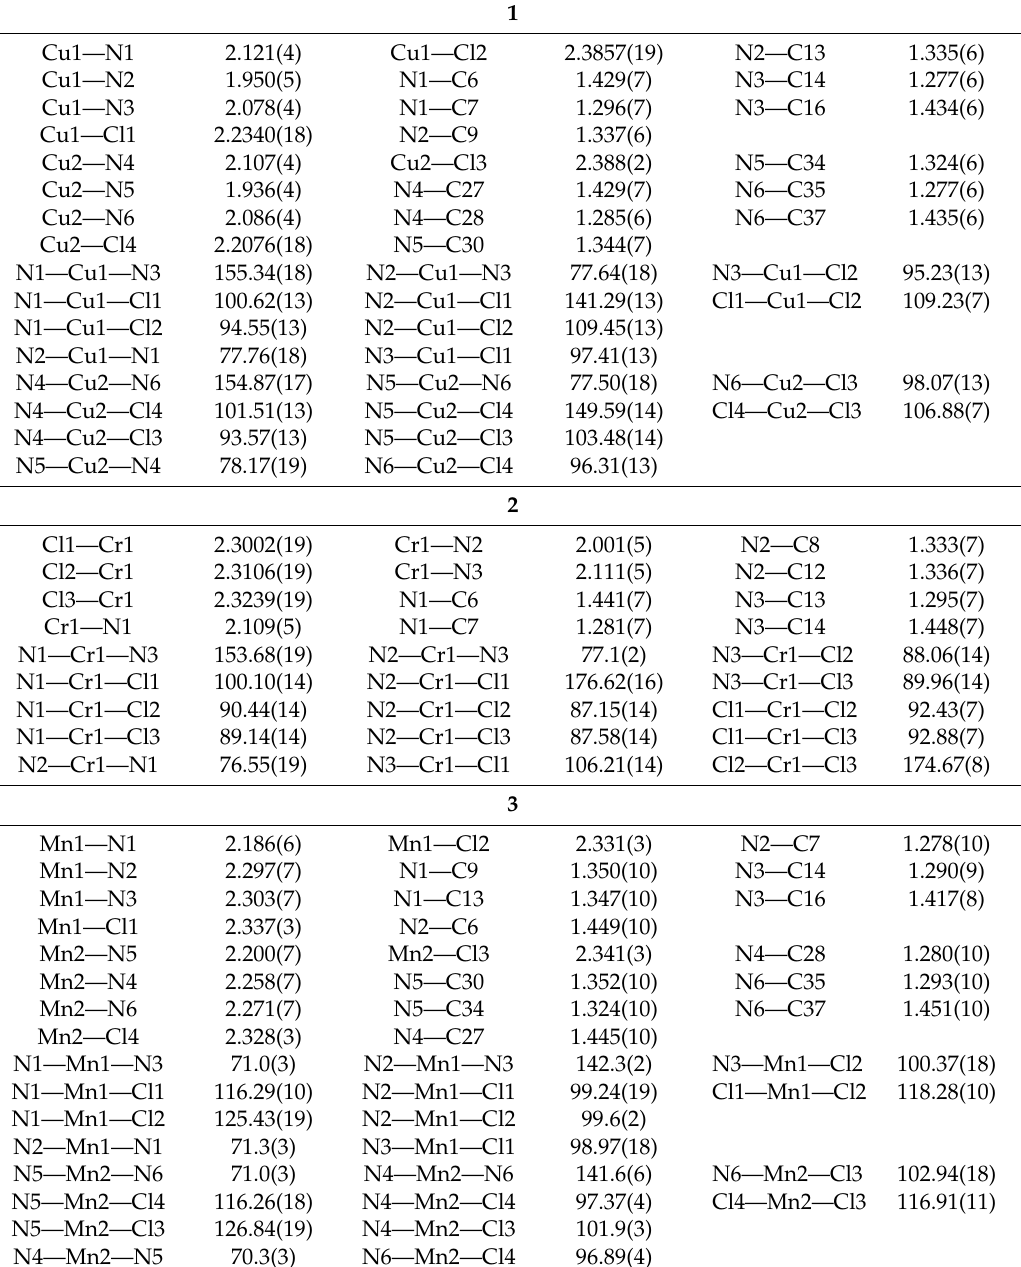
Table 2. Selected bond lengths (Å) and angles ( ◦ ) for complexes 1 – 3